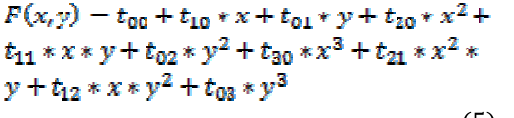
The obtaining point clouds which were resulted from application the introduced chord angle algorithm were used to gives the surface representations of the studied case studies using the facilities of MATLAB program. And the resulted equations for fitting 1- Cylinder case study: 3D degree of an linear polynomial for x and y